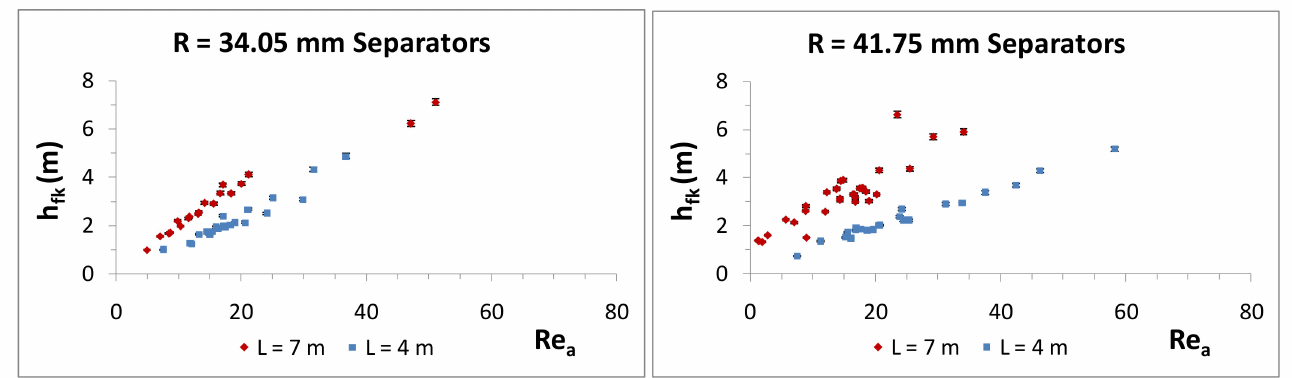
Figure 7. Relationship between the apparent Reynolds number Re a and the head losses h fk (m) for the separators tested with different helix radiuses R (34.05 mm and 41.75 mm) and tube lengths L (4 and 7